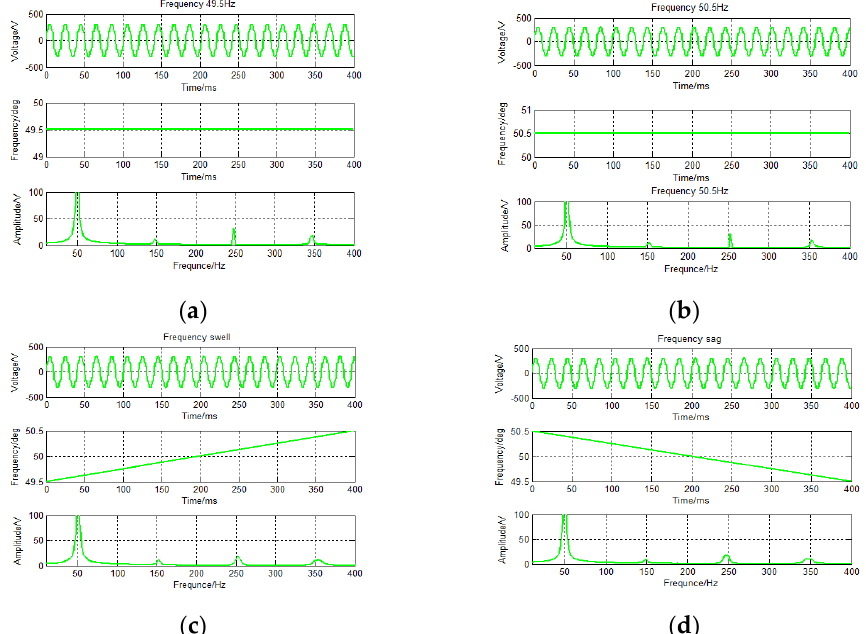
Figure 5. Simulation data for voltage frequency heavy fluctuations. ( a ) Frequency 49.5 Hz; ( b ) Fre- quency 50.5 Hz; ( c ) Frequency swell; ( d ) Frequency sag.